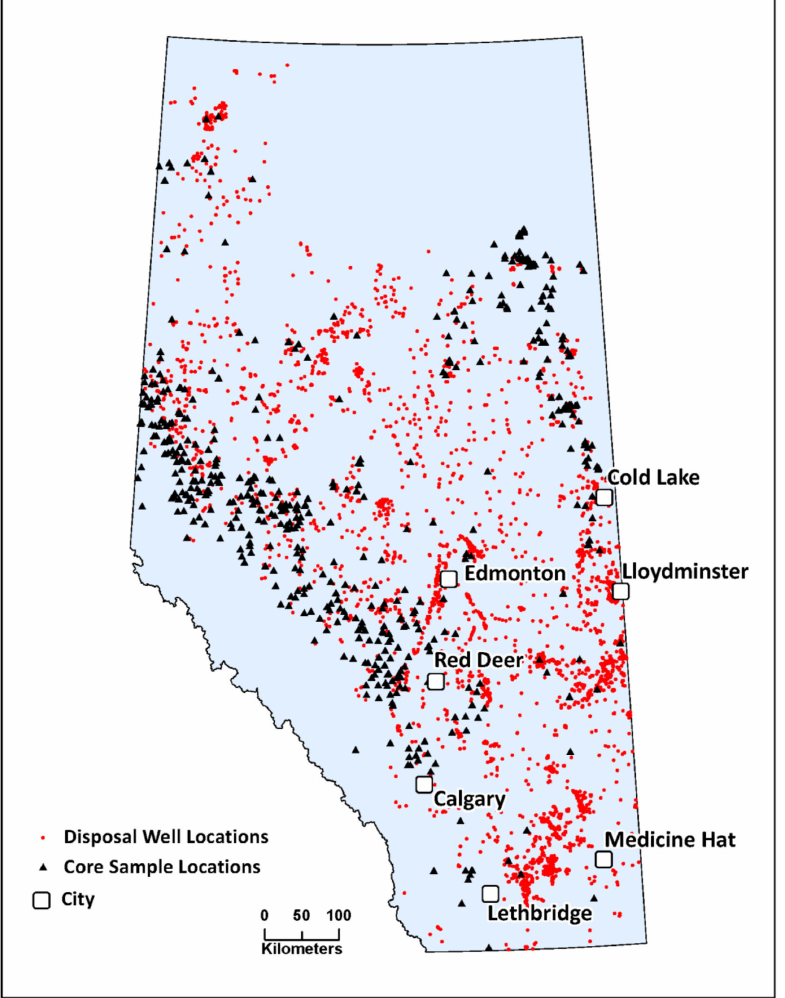
Figure 1. Relative locations of water disposal and core sample wells used in this study. Red dots indicate geographic locations of the approximately 4000 water disposal wells while black triangles indicate the geographic locations of the approximately 260 core sample